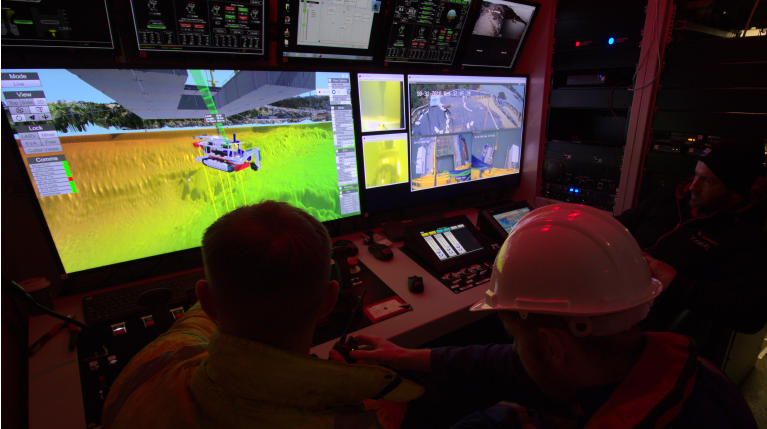
Figure 2. Team of pilots, inside the control cabin, performing the MV deploying maneuver, assisted by the virtual reality